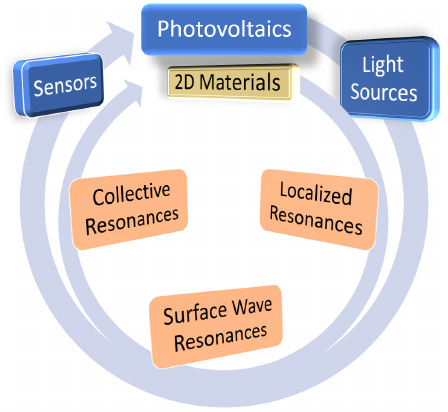
Figure 1. Plasmonic applications, devices, and sensors have gained widespread use in various fields, including biology, chemistry, and environmental monitoring. This review explores a range of plasmonic phenomena, including localized nanoparticle and propagating surface wave resonances, as well as processes in two-dimensional materials and collective multipolar excitations. In addition, this review examines plasmonic applications in enhancing photovoltaic efficiency, creating advanced light sources, and developing better